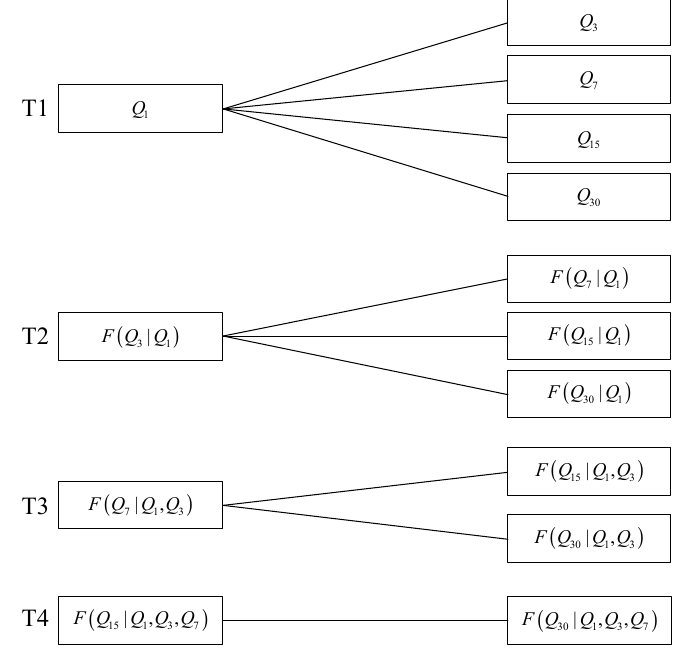
Figure 2. Schematic decomposition of the 5-D C-vine copula.